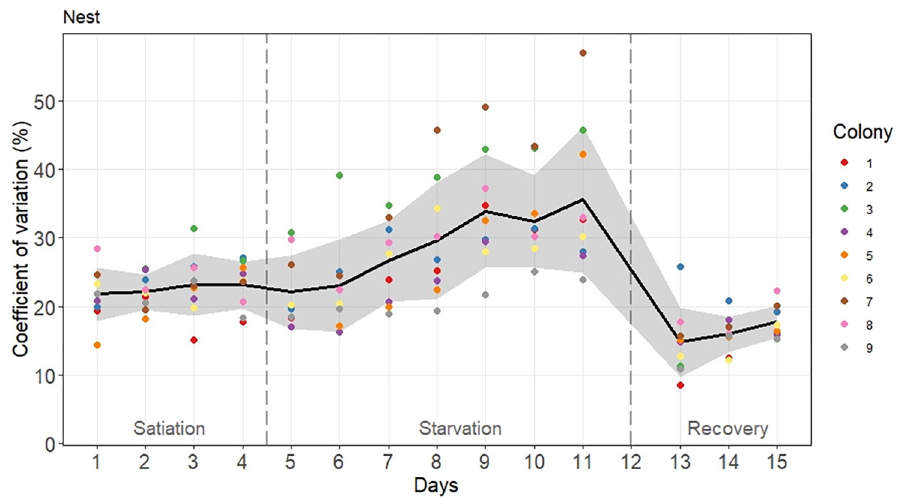
Fig 5. Time evolution of the CV of activity inside the nest over 15 experimental days. Colored points are the daily CVs measured for each of the nine tested colonies. The black line and the grey area are respectively the average value and the standard deviation calculated on the daily CVs of the nine colonies. Food was removed on day 5 and was given back on day 12. Vertical dashed lines separate each experimental phase. https://doi.org/10.1371/journal.pone.0273087.g005 (ANOVA repeated measures P2: F = 2.88, df = 6, P = 0.0177) (S7 Table). During the recovery phase, when colonies gained access to food again, the number of detected activity peaks became lower (Tukey HSD: P1-P3: P = 0.0005 | P2-P3: P < 0.0001; S3 Table), reached at most 8 daily peaks on average and did not significantly change over time (ANOVA repeated measures P3: F = 3.19, df = 2, P = 0.0684).